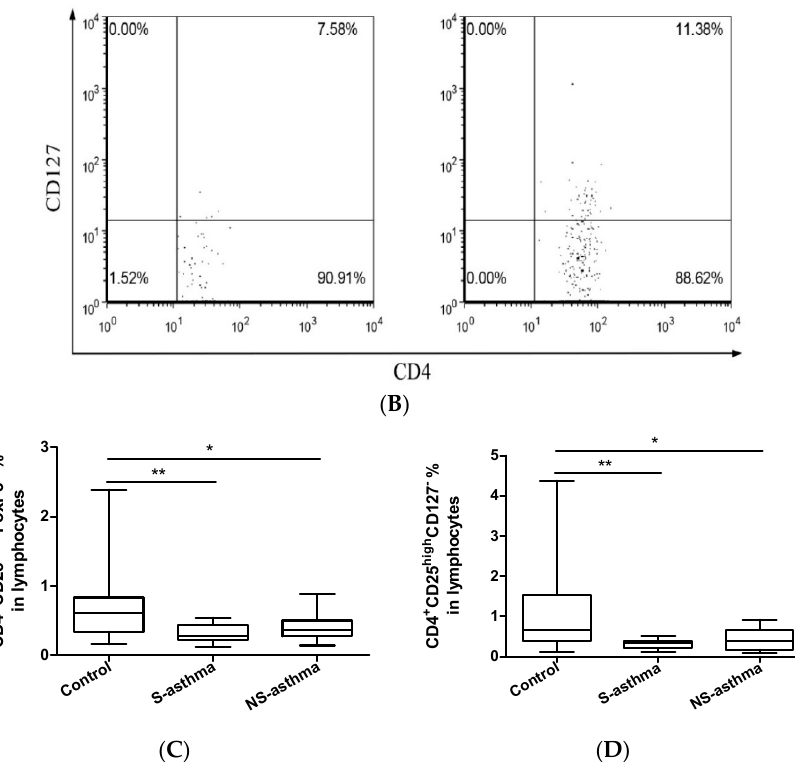
Figure 2. Comparison of circulating CD4 + CD25 high FoxP3 + and CD4 + CD25 high CD127 − Treg lymphocytes percentages between asthmatic patients with or without steroid treatment, and control subjects. Representative dot plots and gating strategy are shown for the ( A ) CD4 + CD25 high FoxP3 + and ( B ) CD4 + CD25 high CD127 − Treg lymphocytes. Briefly, the CD4 + CD25 + cells were gated from total lymphocytes, and then the FoxP3 + or CD127 − cells were gated from the top 20% high CD25 + cells of CD4 + CD25 + cells; ( C , D ) The proportion of circulating Treg lymphocytes in total lymphocytes from asthmatic patients with or without steroid treatment, and control subjects were determined by flow cytometry. Results are presented as box and whisker plots with median (interquartile range). Statistical significances were indicated by * p < 0.05 and ** p < 0.01 (Mann-Whitney U test). S-asthma: steroid-treated asthmatic